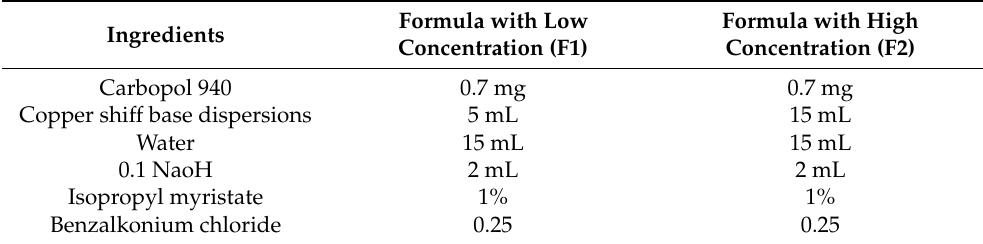
Table 7. Formulation of both concentrations of CuSQ SLNs